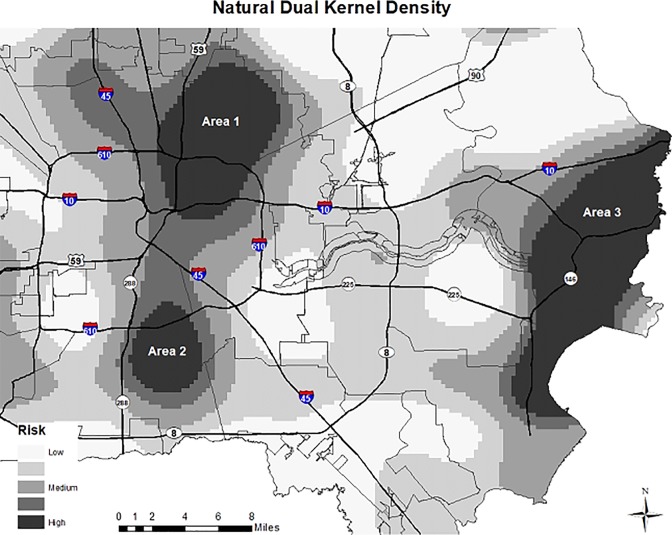
Duel kernel density estimation for premature natural deaths.